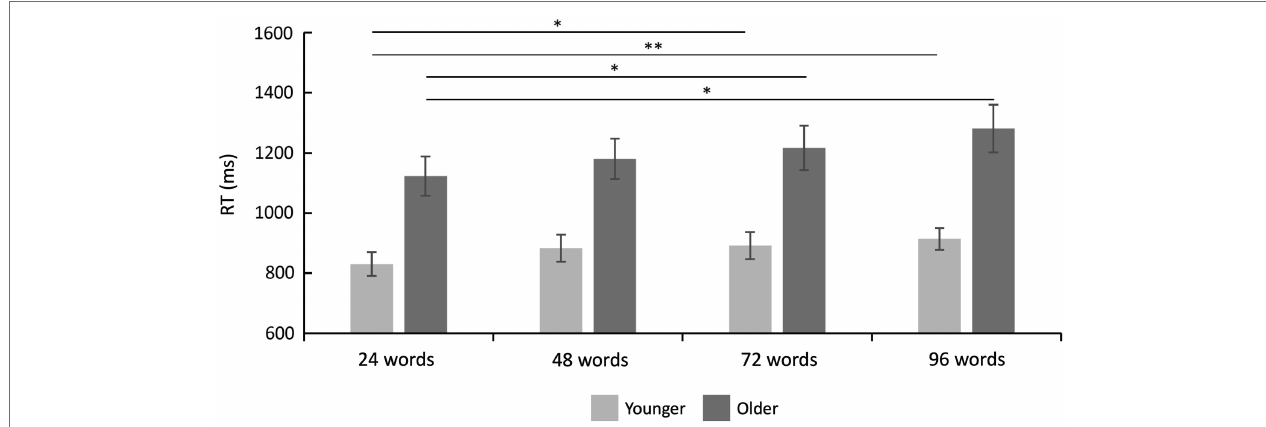
FIGURE 3 | Reaction time results. Reaction times were faster in younger as compared to older adults (main effect of age), and they increased with set size (main effect of set size). There was no significant interaction between set size and age group (see text). Error bars denote one standard error of the mean; * < 0.0041; and ** <